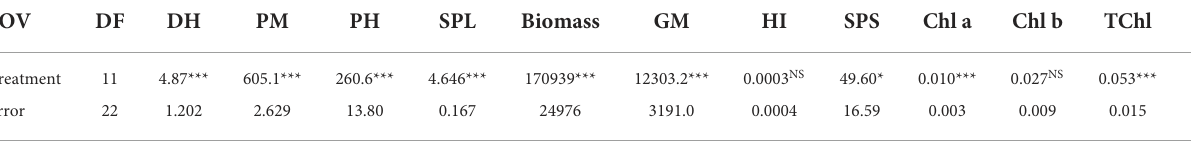
TABLE 1 Mean squares of the different traits in the studied wheat